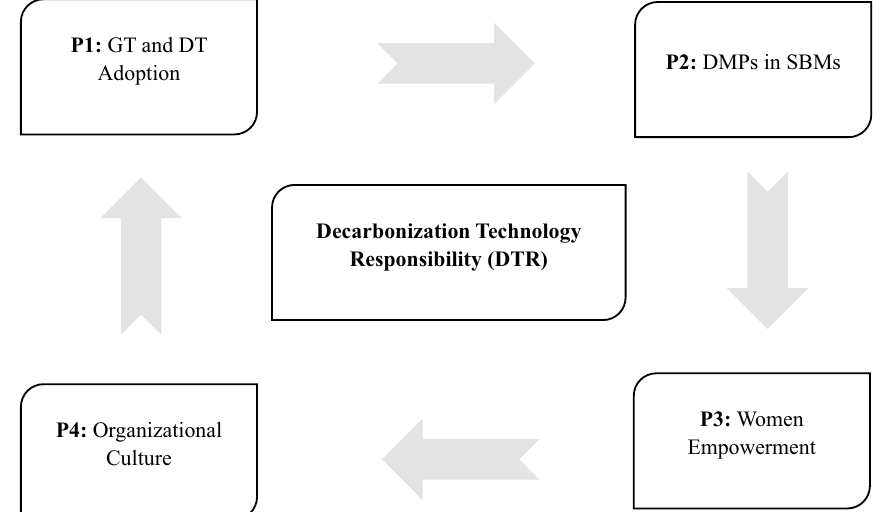
Fig. 3 A conceptual framework of DTR for green technology adoption in SBMs to promote gender equality in shipping